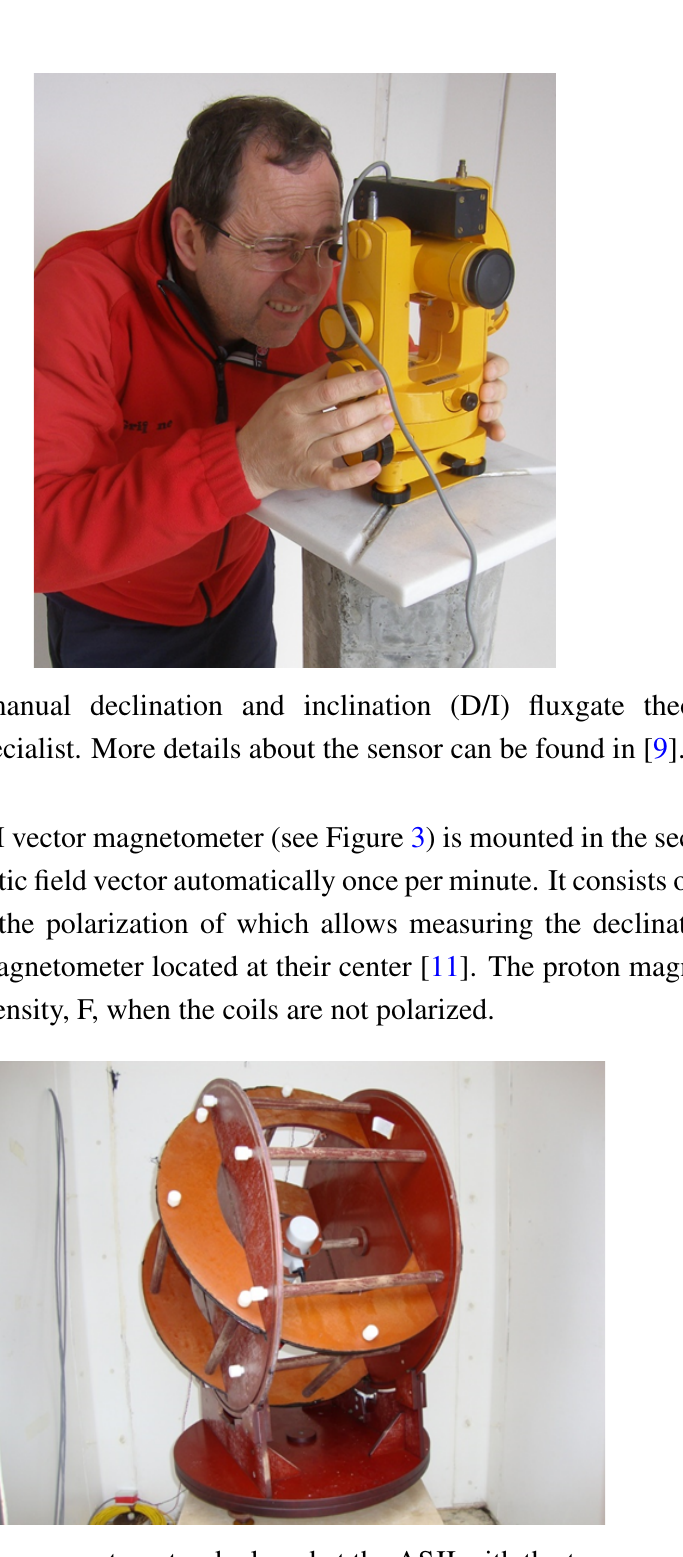
Figure 3. δ D/ δ I vector magnetometer deployed at the ASJI with the two perpendicular pairs of Helmholtz coils and the proton magnetometer allowing one to measure the variations of D/I. More details about the sensor can be found in